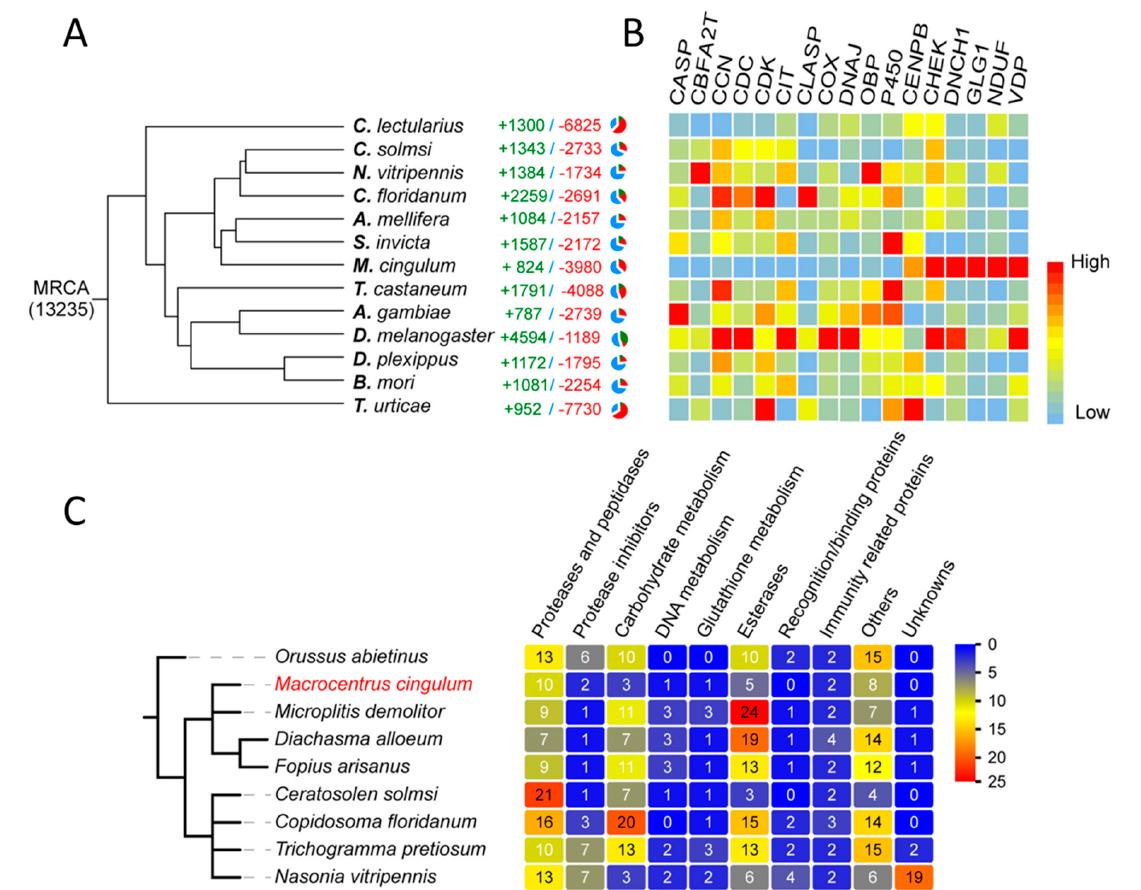
Figure 14. Gene gains and losses of parasitism-associated gene families of Macrocentrus cingulum (Braconidae: Macrocen- trinae) and a range of other hymenopterans. ( A ) Number of gene families with apparent expansion/contraction among M. cingulum and 12 other species. ( B ) Gene families with significant contraction or expansion. ( C ) Numbers of venom proteins in different parasitic wasps. (Source: from [54] reproduced under the terms of Creative Commons Attribution Licence CC-BY 4.0 via BMC Genomics ).